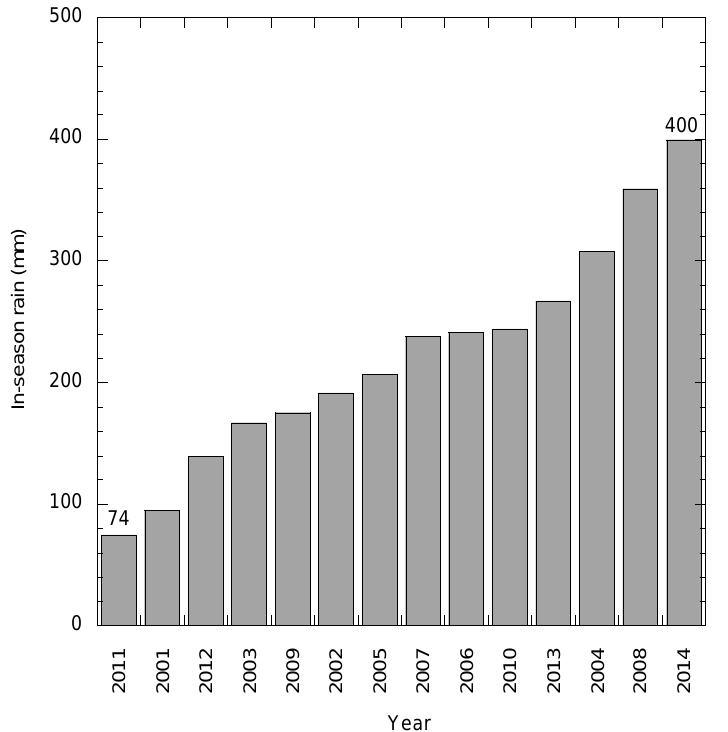
Figure 1. The total rain at Lubbock, Texas during the 150-day interval between 15 May and 12 October for the 14-year period, 2001 to 2014. Data from historic weather at the study site.